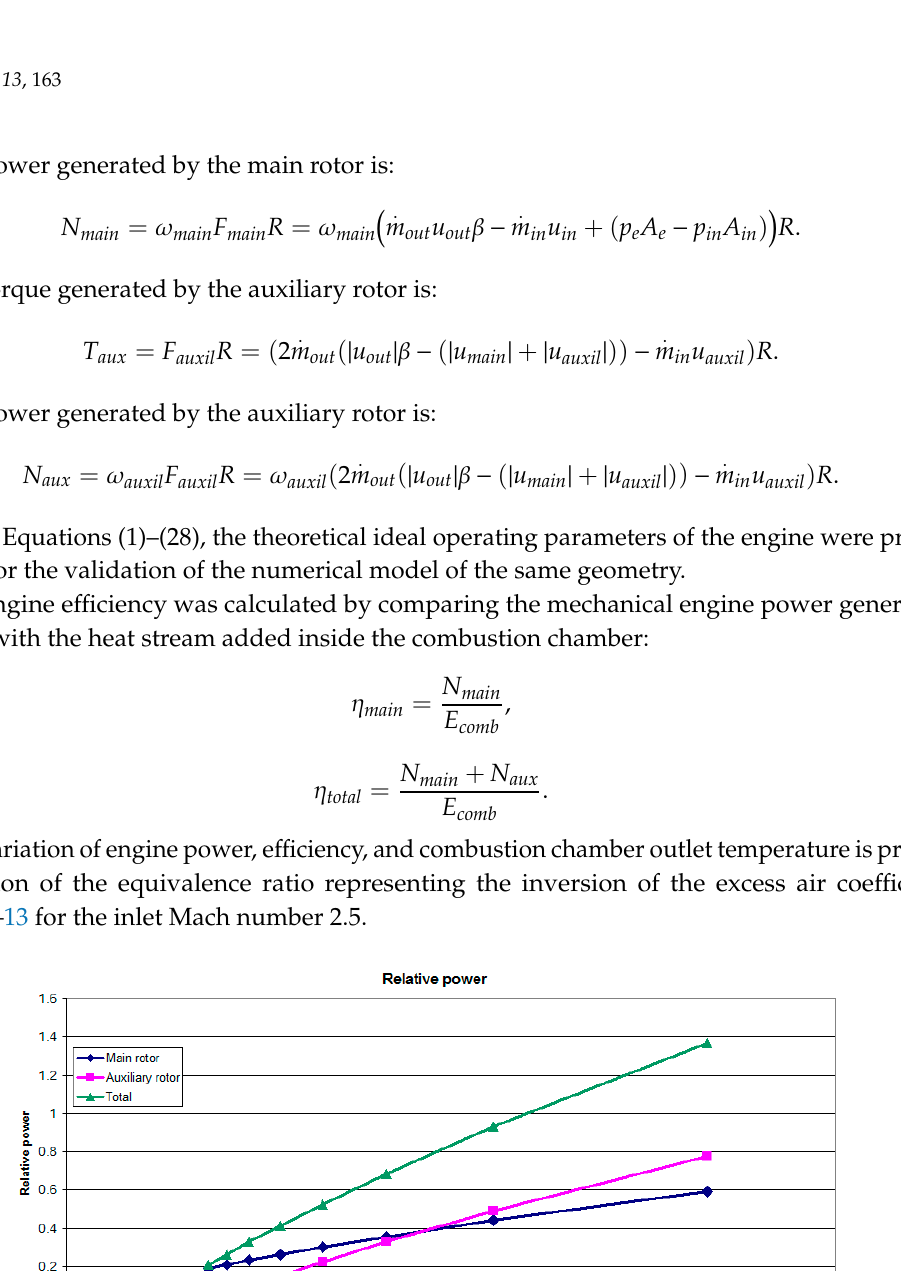
Figure 12. Efficiency of the main rotor and double-rotor engines for the range of inlet Mach numbers as a function of the equivalence ratio.